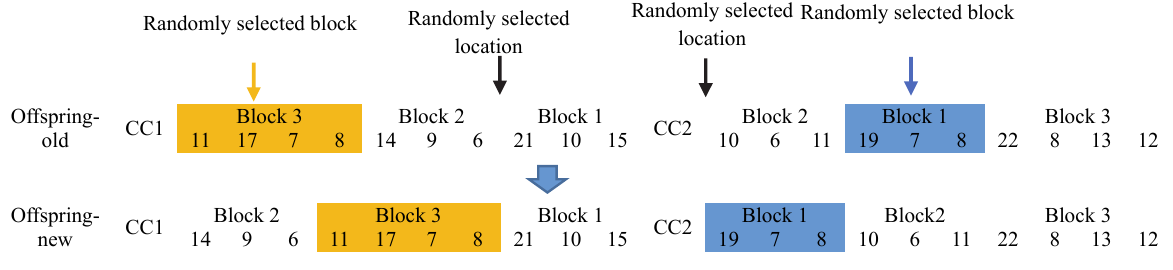
Fig. 4. Illustration of crossover